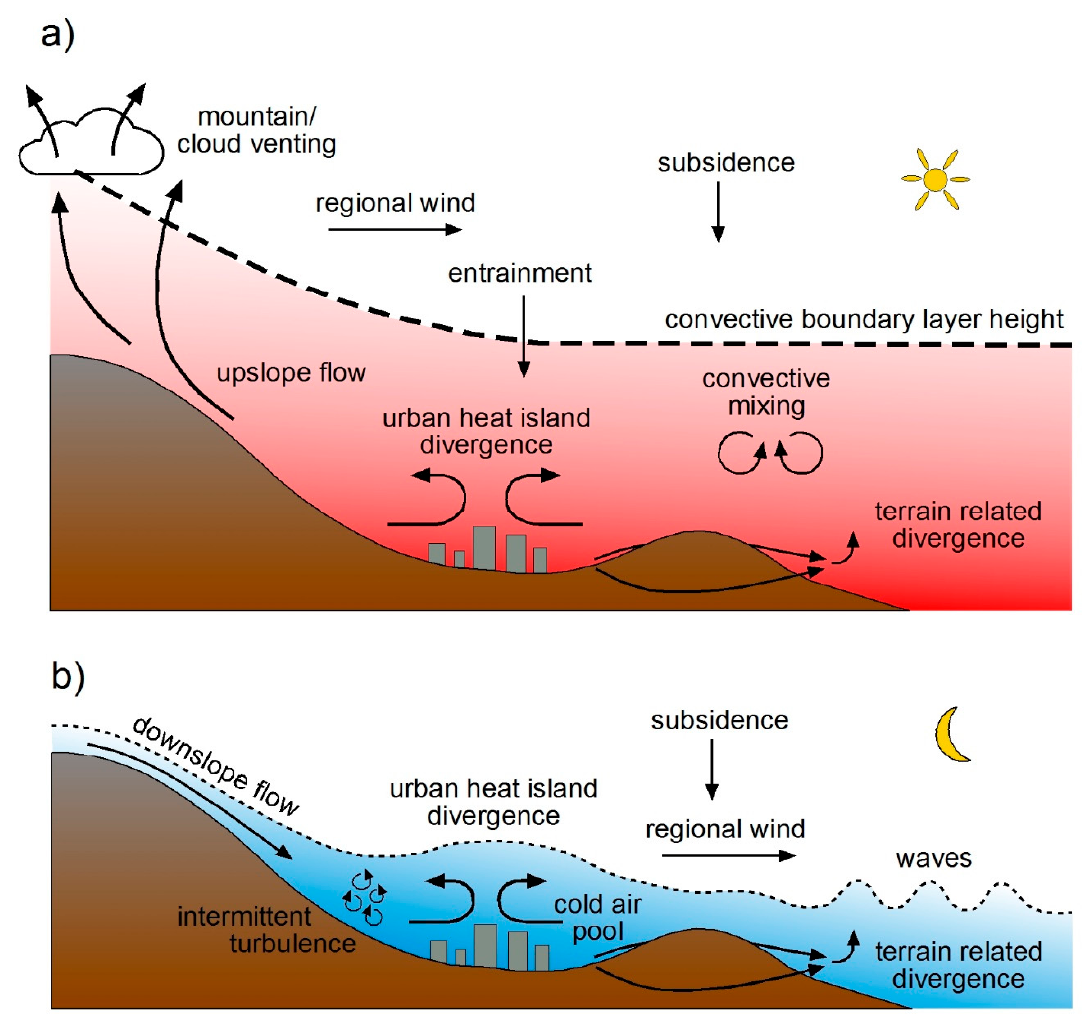
Figure 8. Schematic representation of processes affecting the dispersion of air pollutants in an unstably ( a ) and stably ( b ) stratified boundary layer over complex terrain. Note that similarities between daytime and nighttime situations are the synoptic-scale subsidence, the urban heat island divergence (caused by the relatively warm urban areas compared to the surrounding areas), the regional wind, and the terrain related divergence (caused by the westerly regional wind).